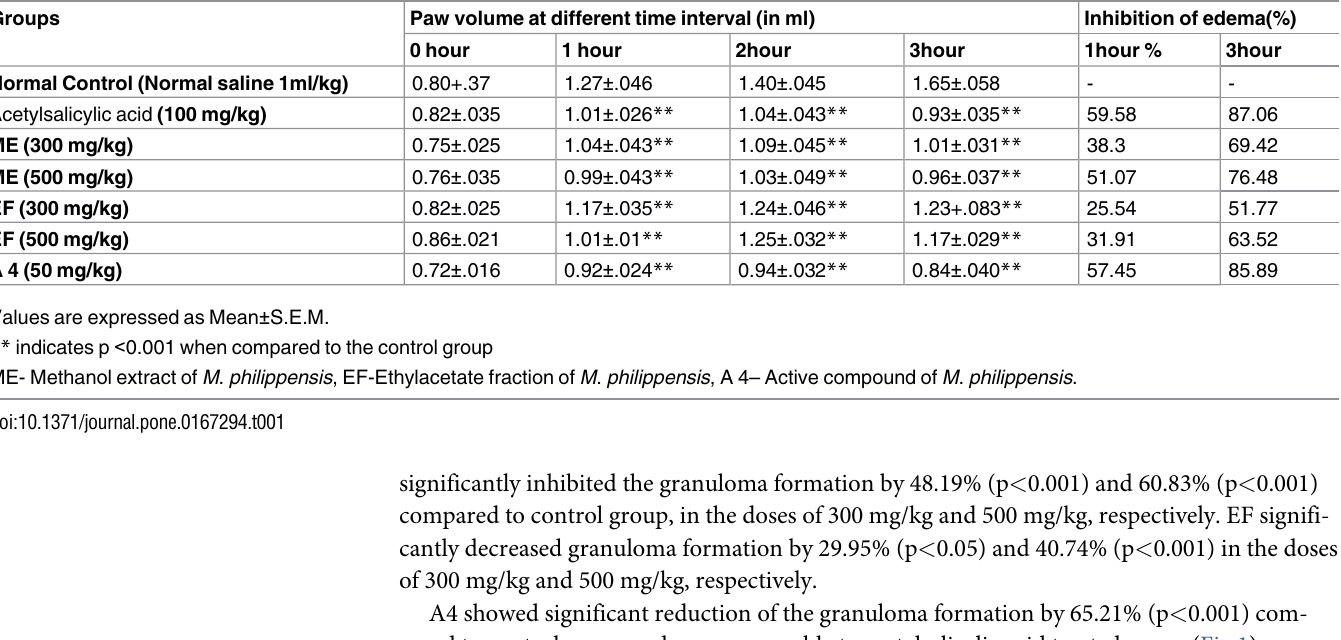
compared to control group, in the doses of 300 mg/kg and 500 mg/kg, respectively. EF signifi-